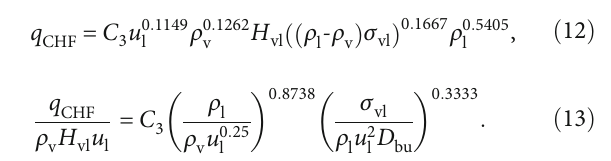
LFP versus E LFP